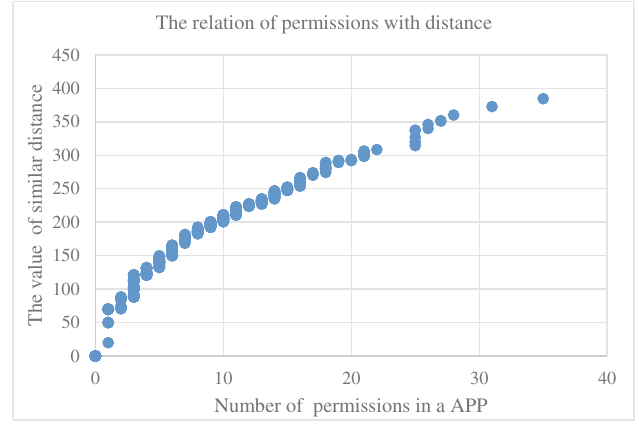
Fig. 4. The relation of permissions with distance